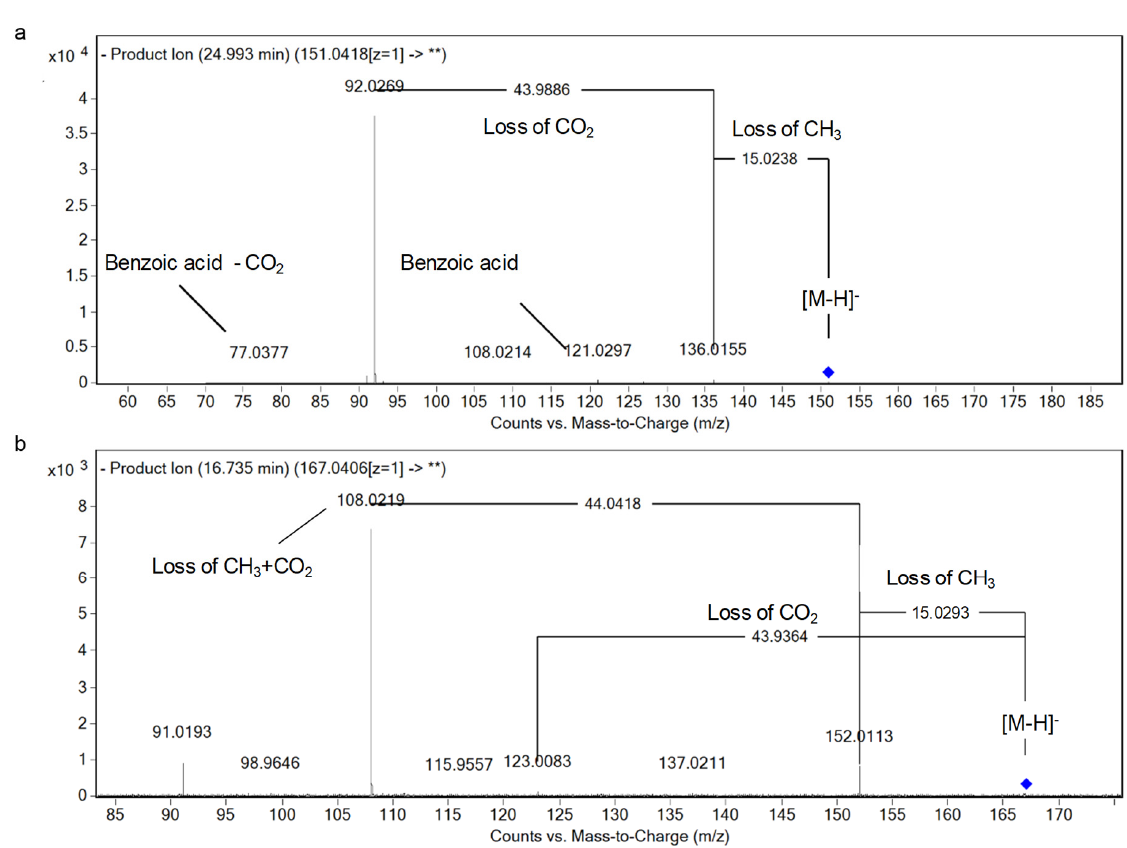
Figure 2. The patterns of fragmentation of ( a ) methoxybenzoic acid II and ( b ) vanillic acid.